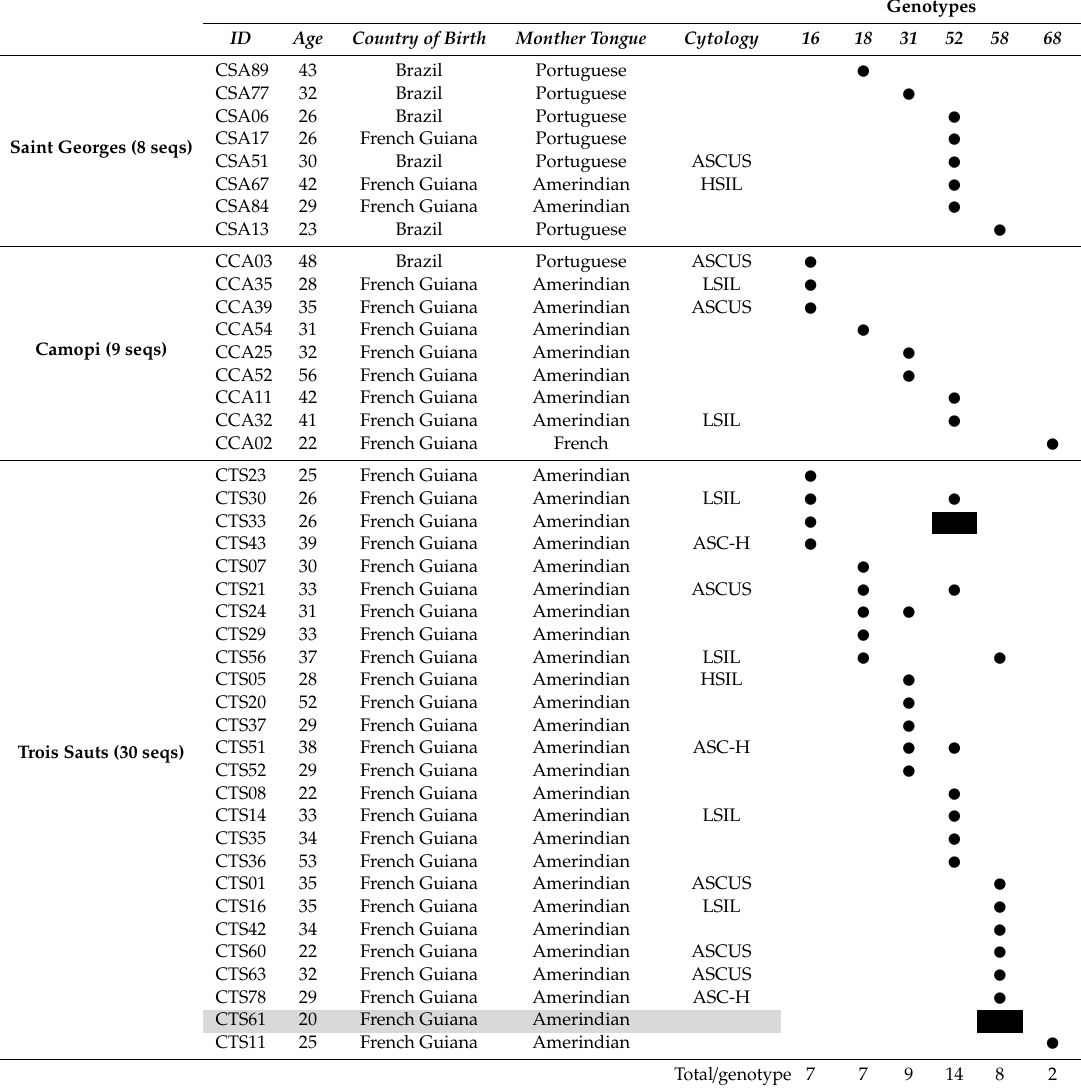
Table 1. HPV genotypes identified on the Oyapock, classified by villages.